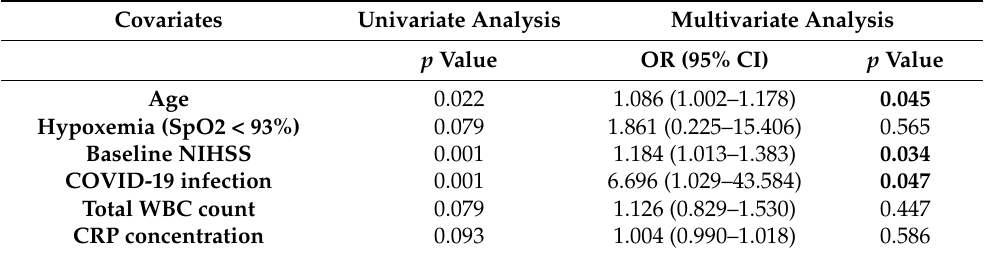
Table 5. Logistic regression model on the likelihood of 3-month mortality after stroke and reperfusion therapy ( n =